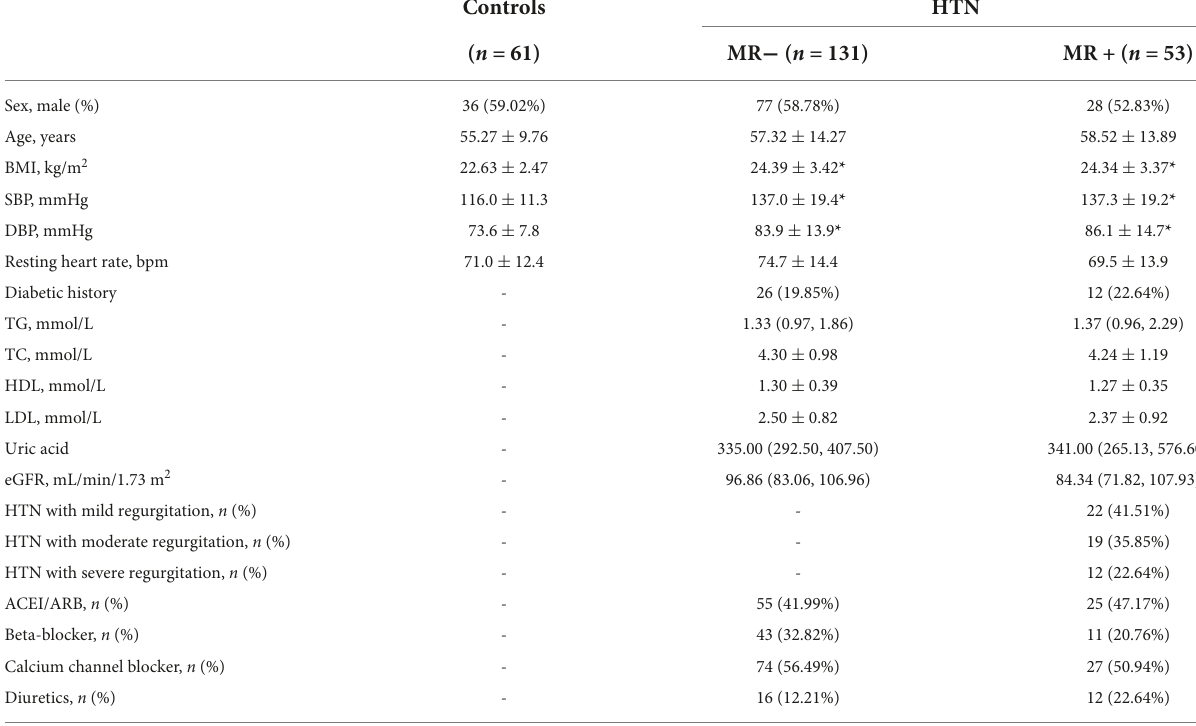
TABLE 1 Baseline features of the study